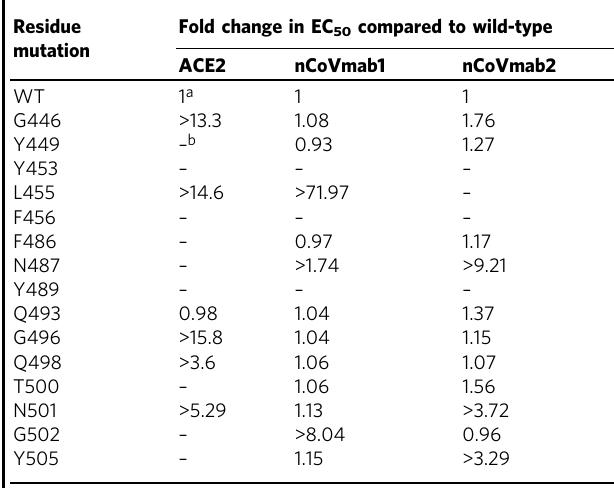
Table 1 Fold change in EC 50 binding activity compared to wild type. Residue